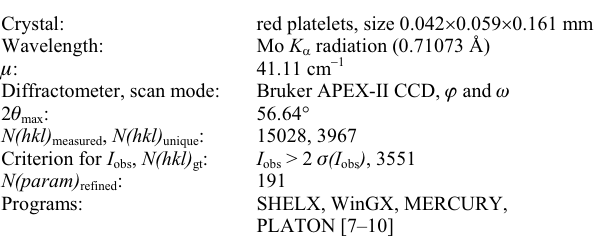
Table 1. Data collection and